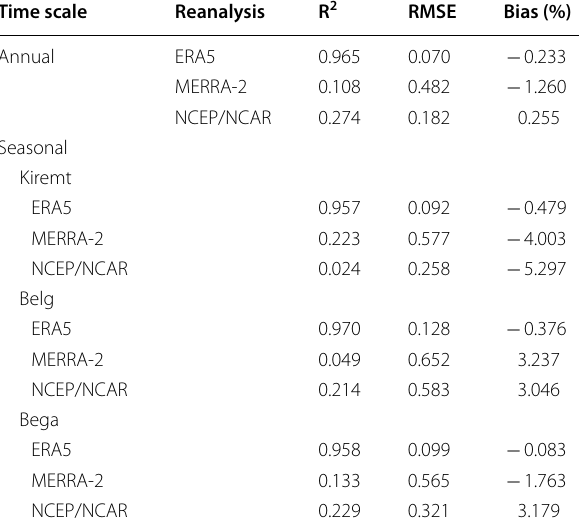
Table 2 Evaluating reanalysis temperature products in the lake basin